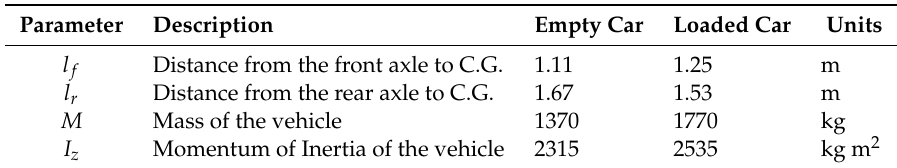
Table 1. Parametric variation of a Sedan-D